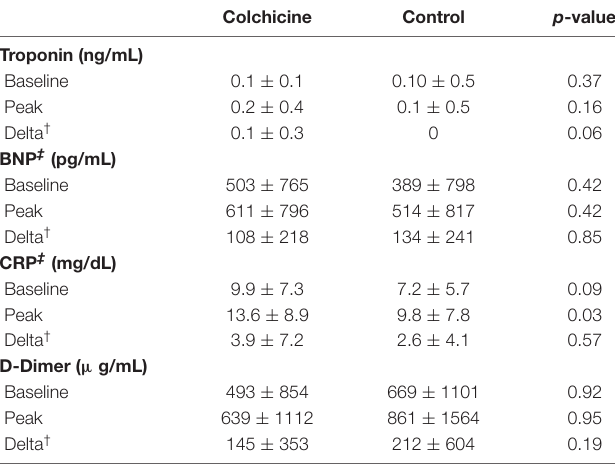
TABLE 3 | Cardiac and inflammatory